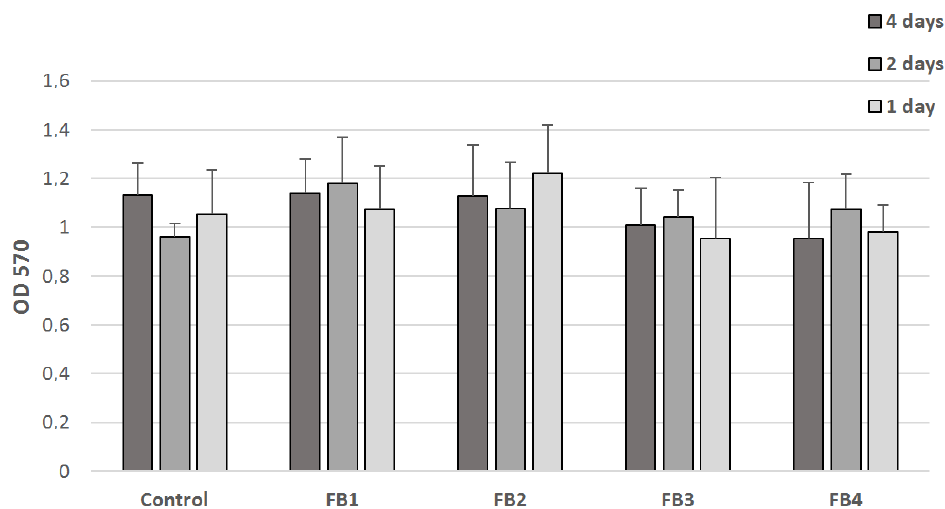
Figure 5. Evaluation of the cytotoxicity of polymer films FB1 – FB4 for UC MSCs: the results of MTT test after one, two, and four days of incubation.